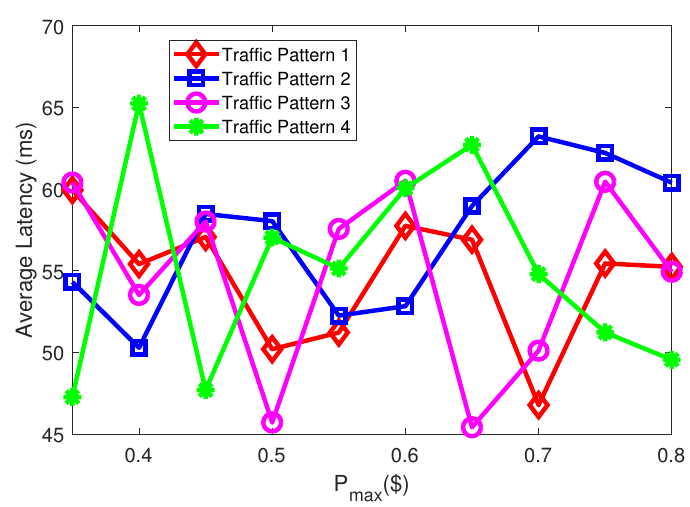
Figure 19. Impact of P max on average latency in